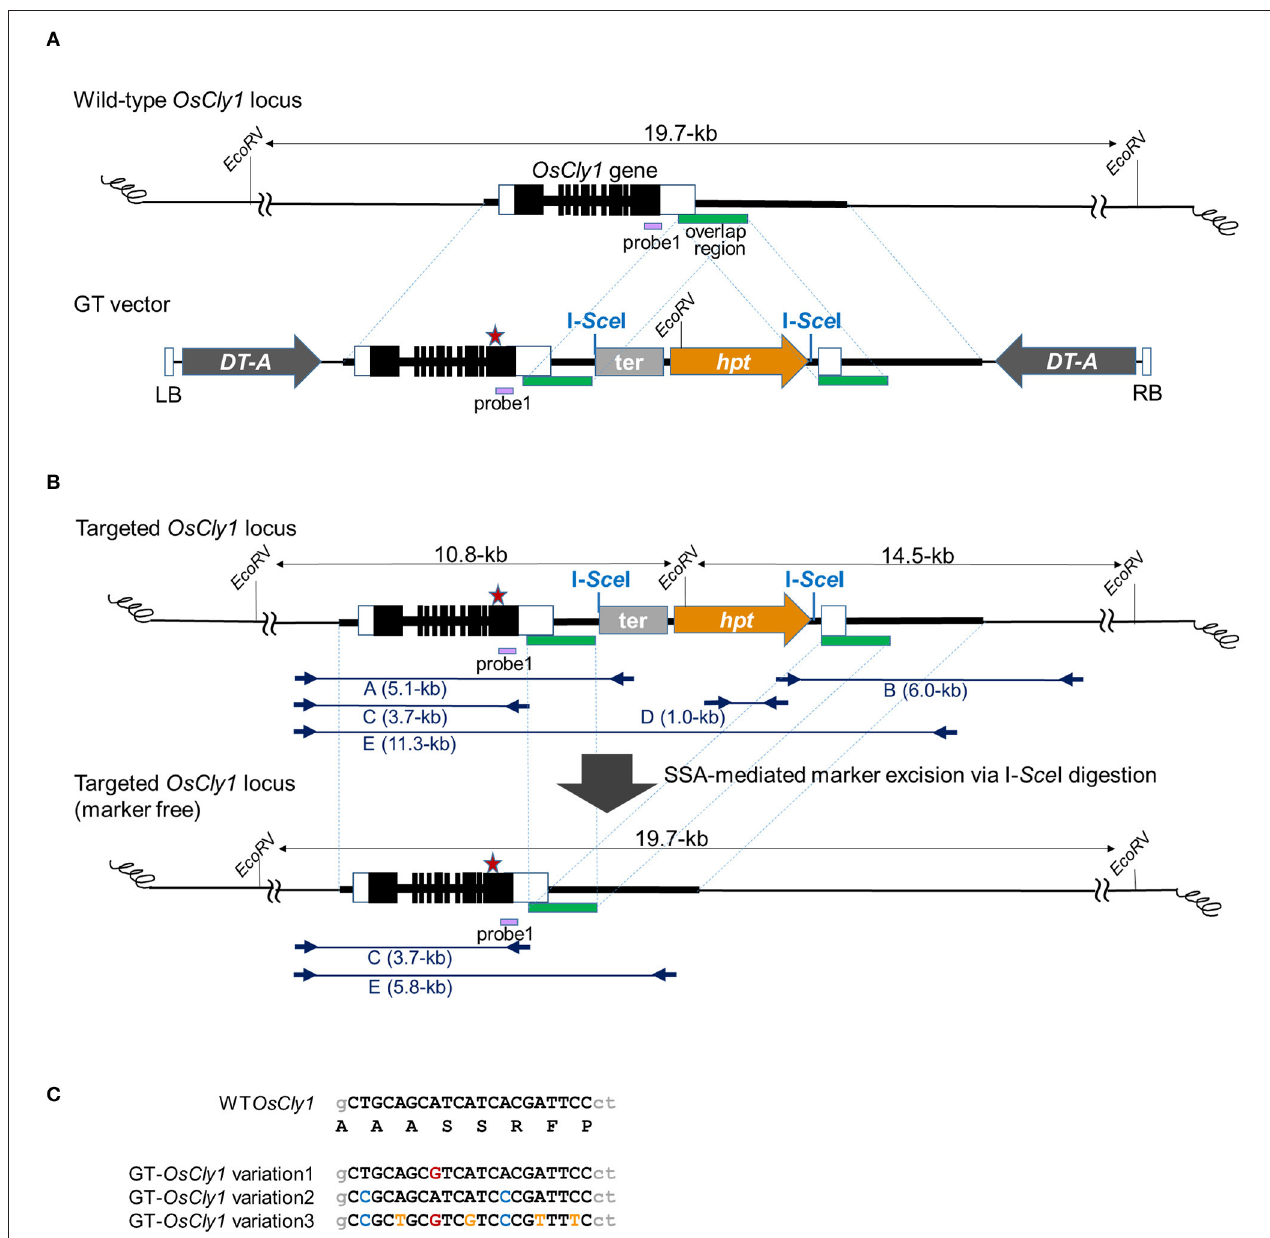
FIGURE 1 | Strategy to introduce desired substitutions into the OsCly1 gene via GT and subsequent SSA-mediated marker excision. (A) Schematic representation of GT at the OsCly1 locus. The upper line indicates the wild-type (WT) OsCly1 locus. White and black boxes indicate untranslated and coding regions of OsCly1 gene, respectively. The lower line indicates the T-DNA region of the GT vector. The black bar indicates homologous regions of the OsCly1 locus with 1.2-kb overlapped sequences (green bar). The red star indicates position of desired substitution(s). The GT vector carries the rice actin gene terminator (ter) and hpt gene under the control of the CaMV 35S promoter as a positive selection marker, and DT-A genes under the control of maize polyubiqutin1 promoter or rice elongation factor 1-alpha promoter as negative selection markers. The purple bar shows probe 1 for Southern blot analyses. LB and RB; left and right borders of T-DNA, respectively. (B) Strategy for marker excision from the GT locus using SSA. The upper line indicates the OsCly1 locus modified by GT via HR between the GT vector shown in (A) and endogenous genome. The lower line indicates the GT-modified OsCly1 locus after SSA-mediated marker excision. Blue arrows show primer sets used for PCR and sequence analyses to confirm GT and marker excision events. (C) Sequence alignments of desired substitution(s) in OsCly1 gene indicated as a red star in (A,B) . Black uppercase letters indicate miR172 target sequences in the OsCly1 gene. The top line indicates the genomic and deduced amino acid sequences of the WT OsCly1 gene. The colored letters in the lower three lines indicate the substitutions in each GT